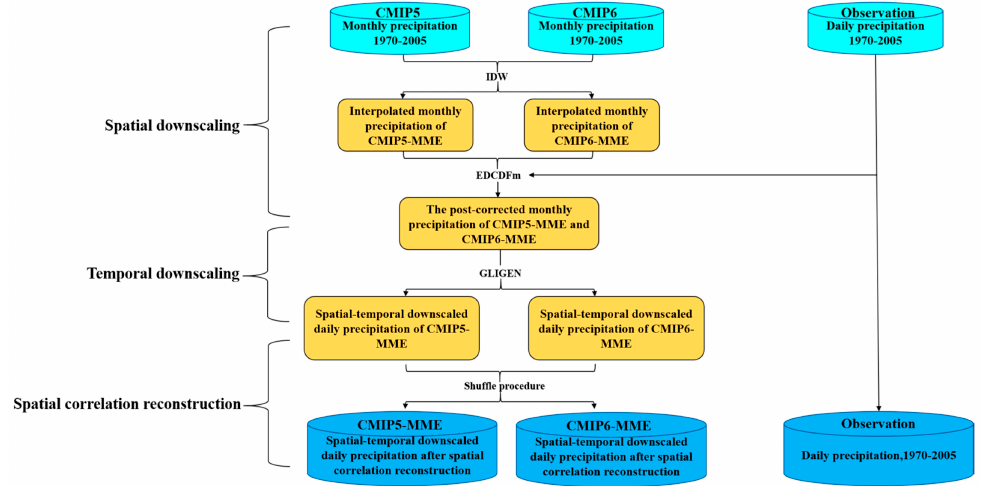
Figure 2. Flowchart of multi-site statistical downscaling framework.